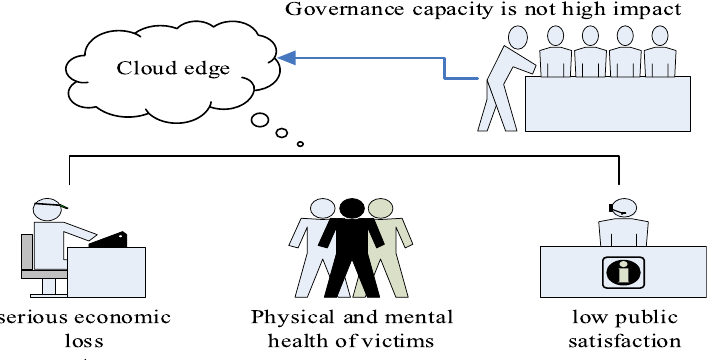
Fig. 6 Impact of low governance